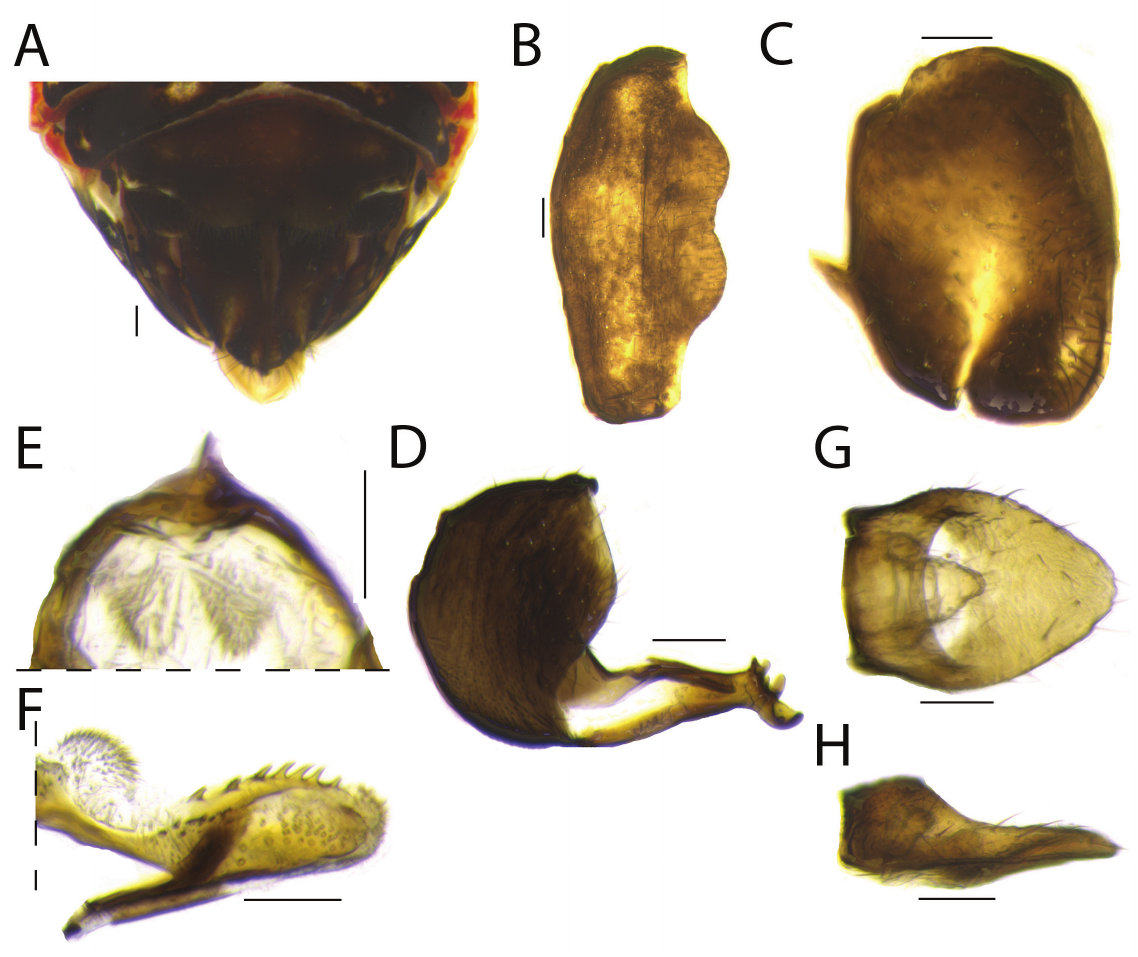
Fig. 23. Female terminalia of Protrocha nigrilutea sp. nov., ♀, paratype (INHS). A . External female terminalia, ventral view. B . Sternite VII, ventral view. C . Gonoplac, lateral view. D . Anterior connective lamina of gonapophysis VIII, ventral view. E–F . Posterior connective lamina of gonapophysis IX. E . Connective part in dorsal view. F . Distal part in lateral view. G–H . Anal tube. G . Dorsal view. H . Lateral view. Scale bars = 0.1